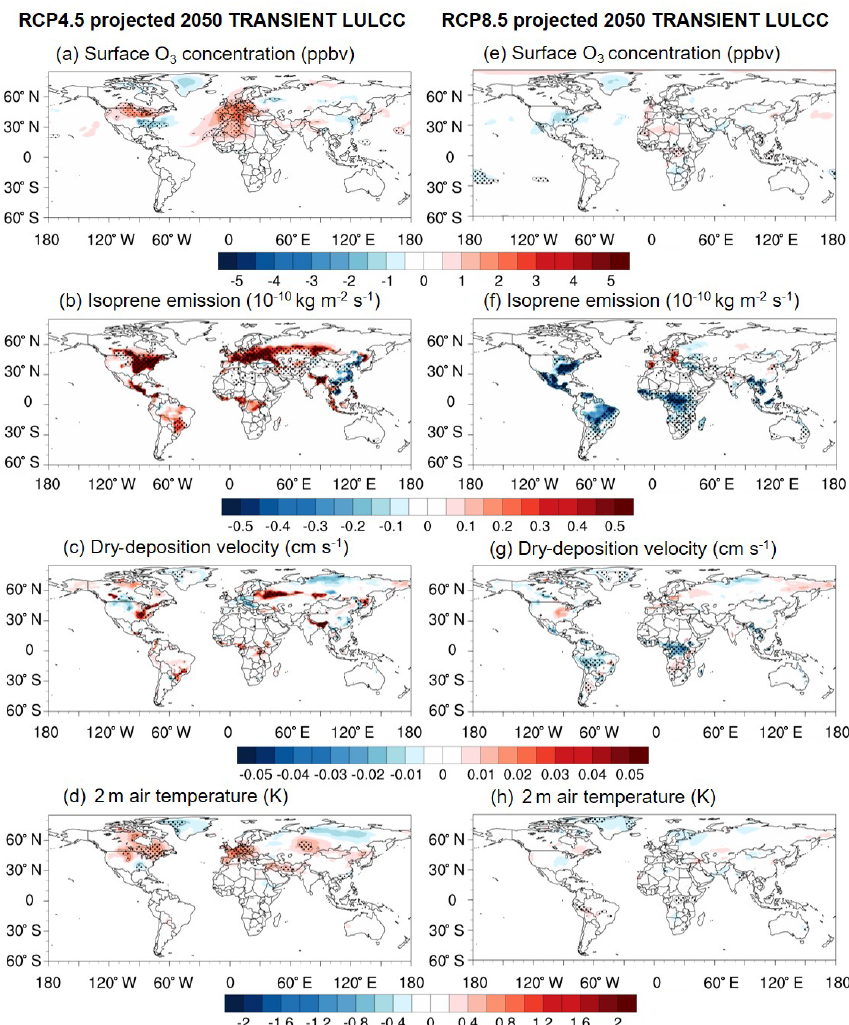
Figure 7. Similar to Fig. 4, but these results are from the transient simulations On-line_45 and On-line85 (Table 1), averaged over the two ensemble members for each